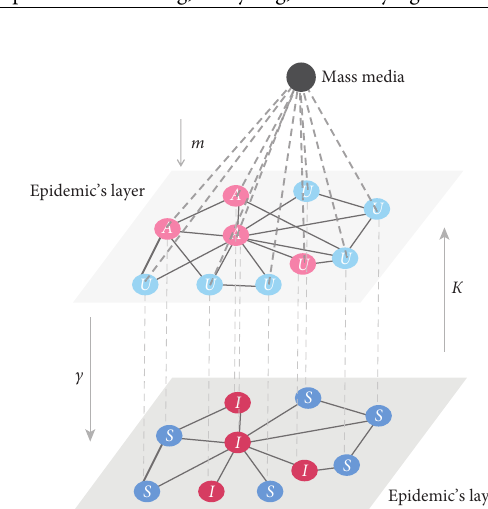
Figure 3: Awareness-epidemic model in the presence of mass media: the upper (information) layer is supporting the spreading of awareness, and nodes have two possible states: unaware (U) or aware (A). The lower (epidemic) layer corresponds to the network where the epidemic spreading takes place. The nodes are the same actors as in the upper layer, but here their state can be susceptible ( S ) or infected ( I ). The mass media are represented as a top node that provides information to the full system